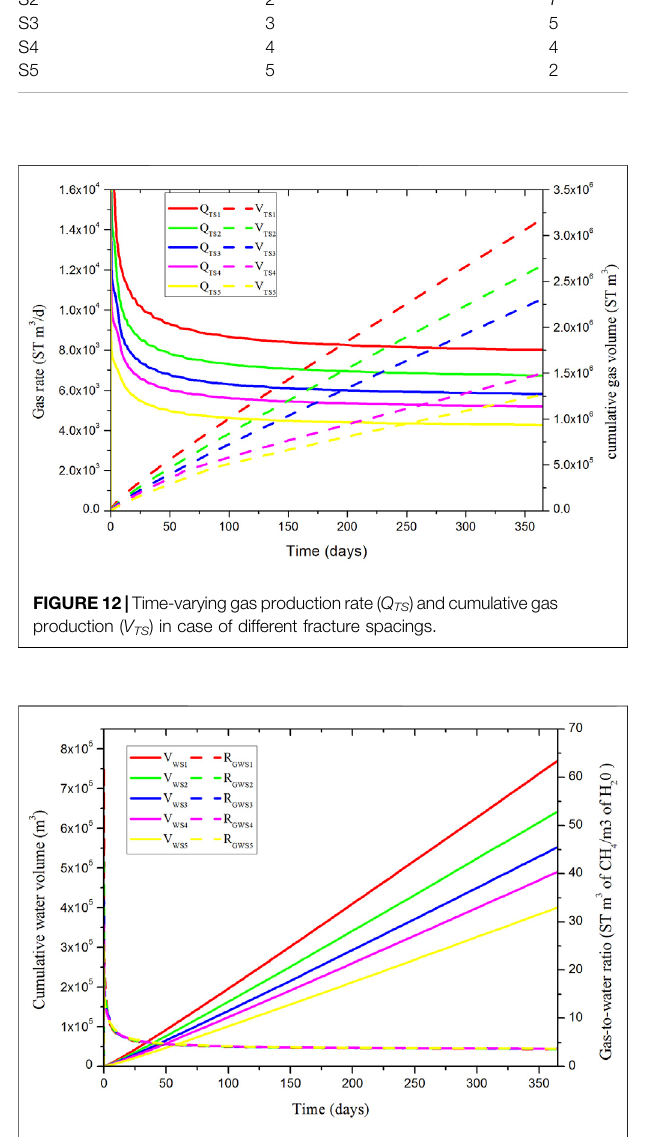
FIGURE 13 | Time-varying cumulative water production (V WS ) and gas – water ratio (R GWS ) in case of different fracture